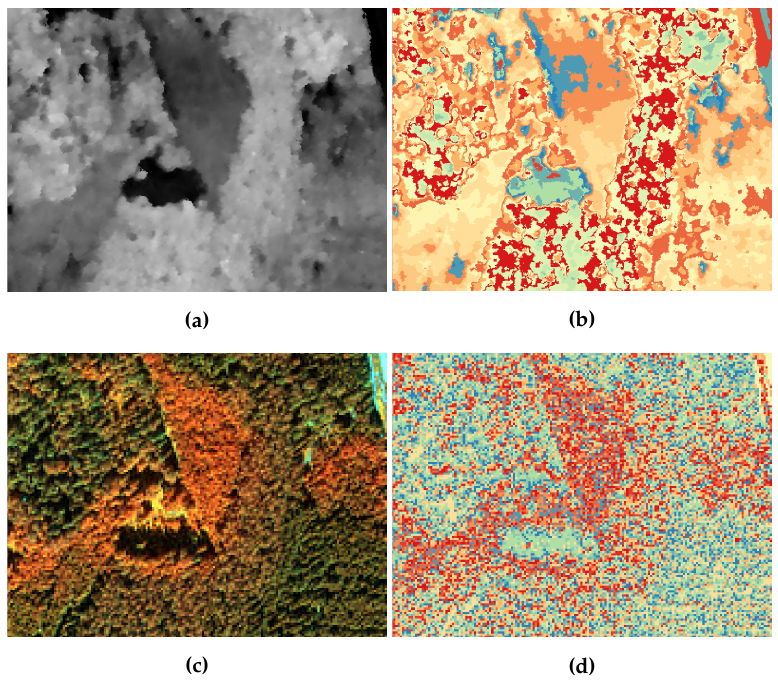
Figure 2. Examples of class-map images. a) GeoEye-1 based CHM, b) class-map image of a) if 16 clusters are sought by k-means, c) GeoEye-1 based false colour image (NIR, Green, Blue), d) class-map image of c) if 16 clusters are sought by k-means.